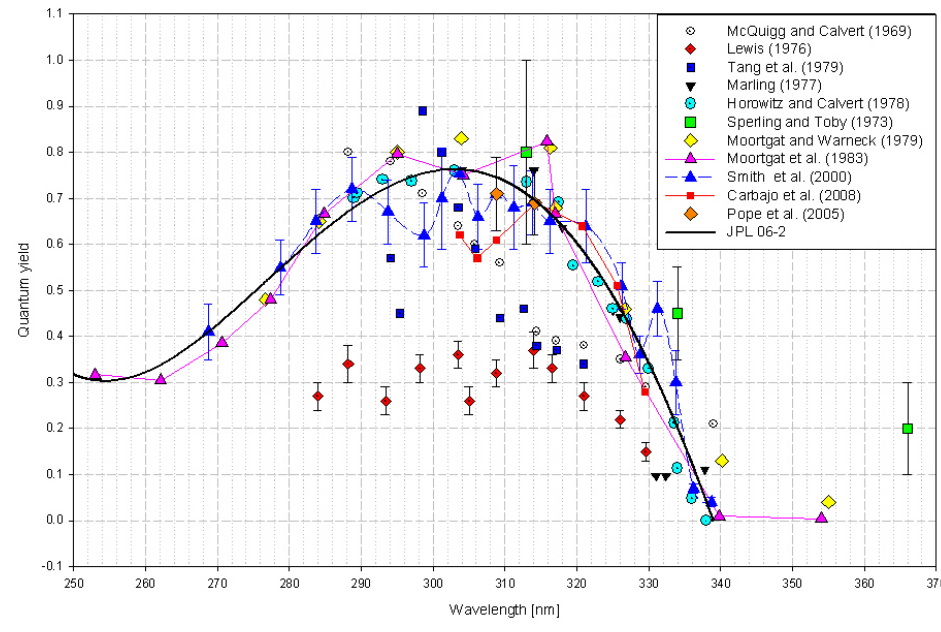
ν → H + HCO. Figure 2. Overview plot of measured quantum yields CH 2 O h Table 5. Example for metadata associated with a quantum yield data set. The corresponding data file is shown in Table 6. Quantum Yields / Organics (carbonyls) / Aldehydes(aliphatic) / CH2O → H + HCO